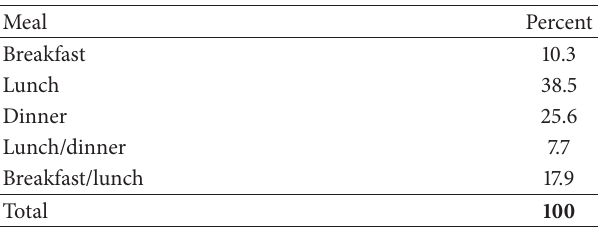
Table 3: Frequency of D. steriscus meals for Bindura high density